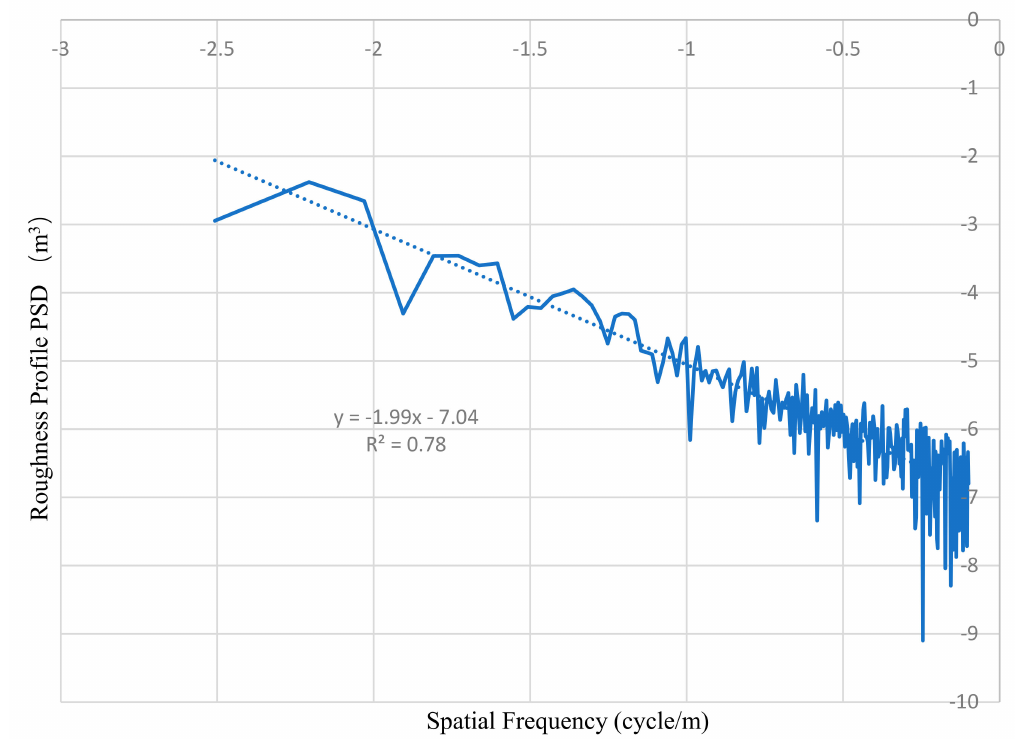
Figure 19. Roughness profile PSDs versus spatial